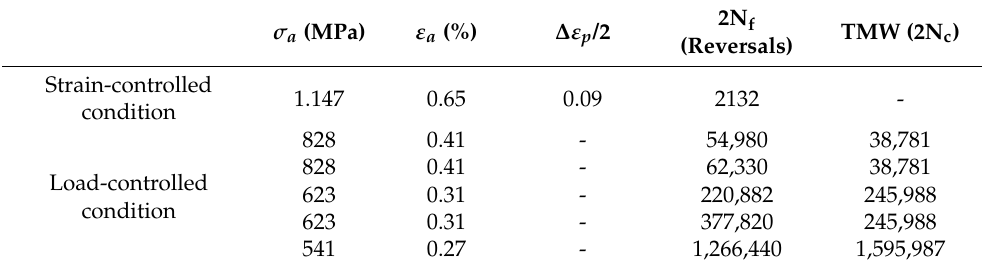
Table 4. Fatigue test results of CA-H1025 heat-treated AM 17-4 PH stainless steel with the machined surface under axial loading (test information and data taken from [13]).